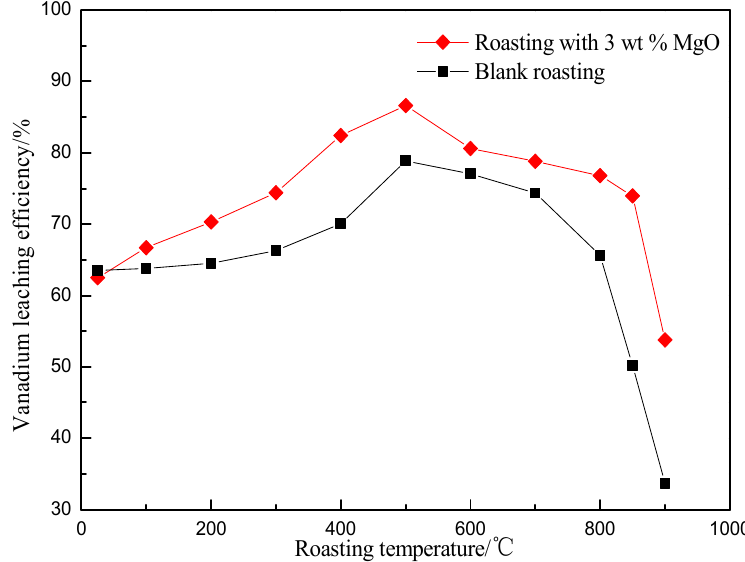
Figure 2. Effect of roasting temperature on vanadium leaching efficiency.